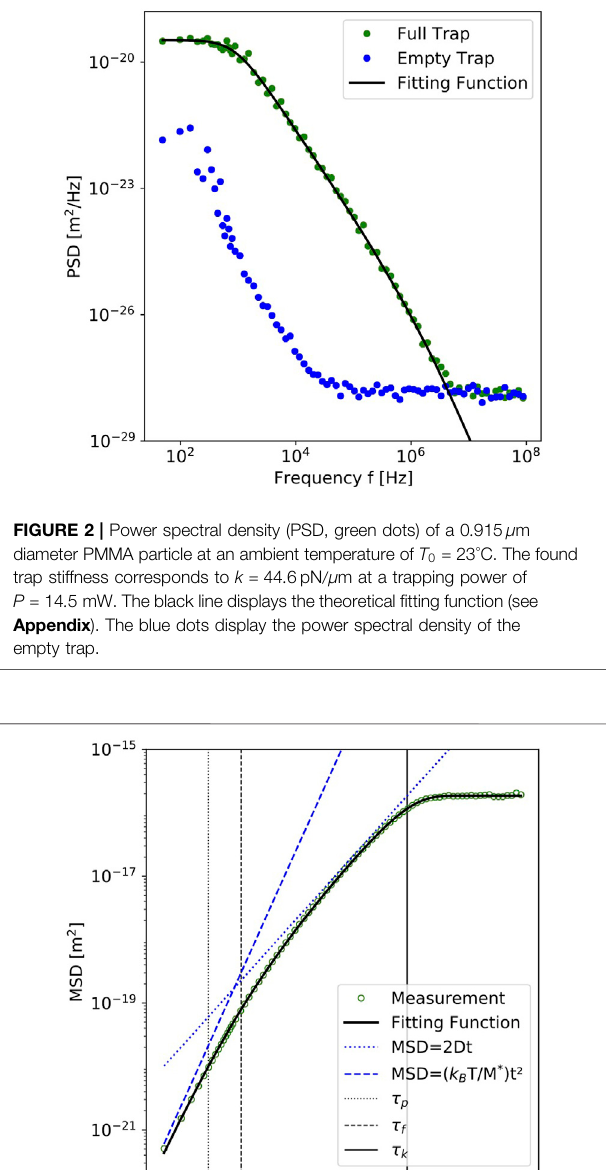
Frontiers in Physics |